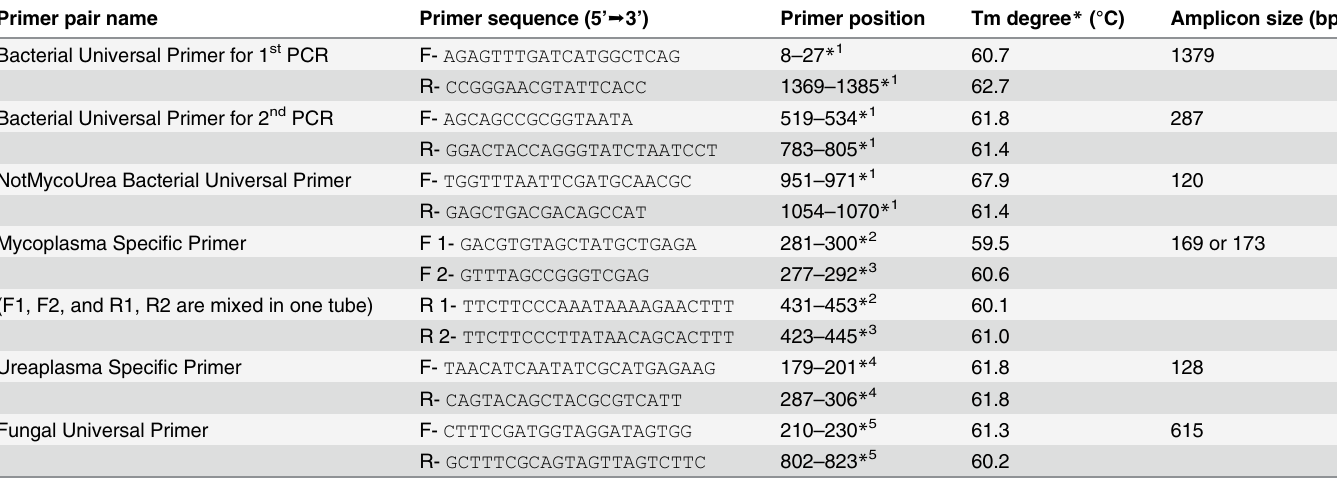
Table 1. The PCR primers and amplicon sizes in base